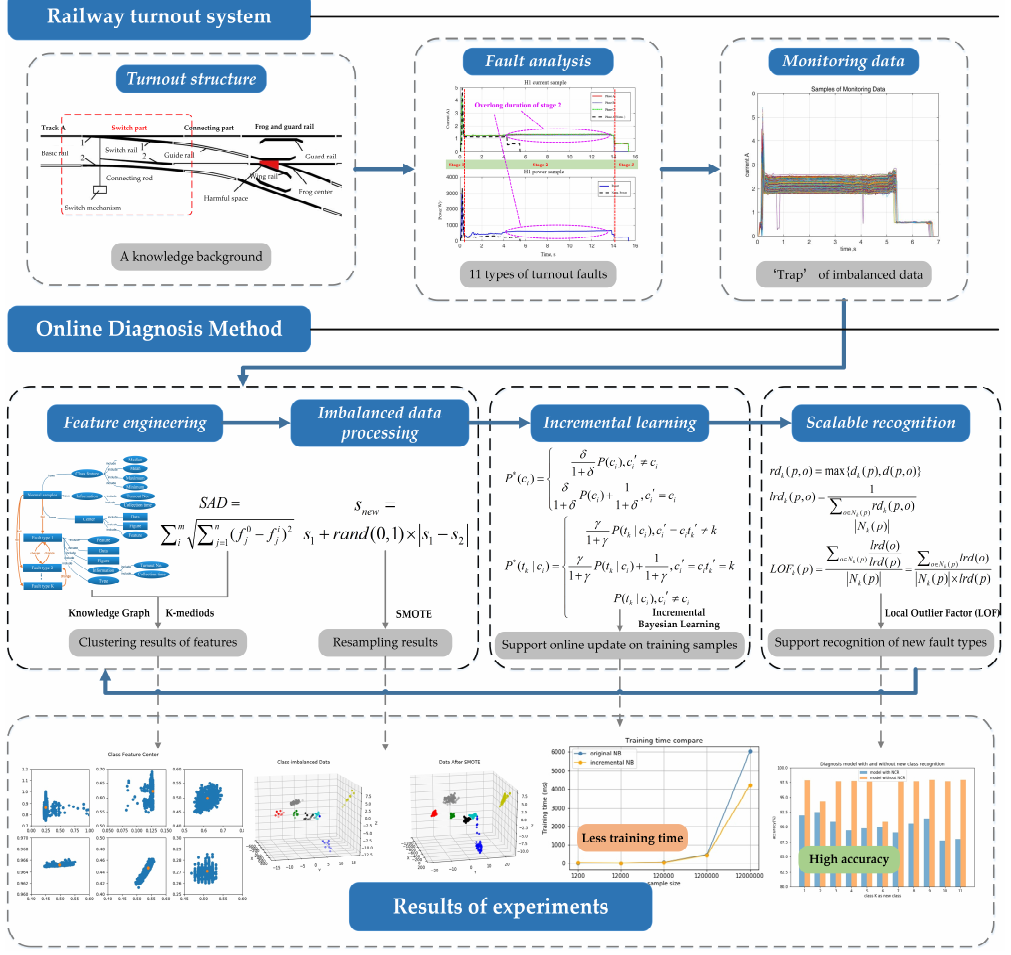
Figure 1. Research framework of this